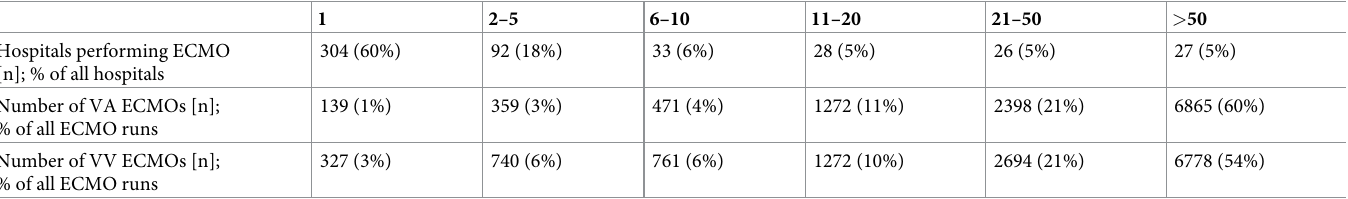
Table 1. Number of hospitals performing ECMO arranged in categories (mean annual ECMO volume over all 6 years) and total numbers of vvECMO and vaECMO per hospital category from